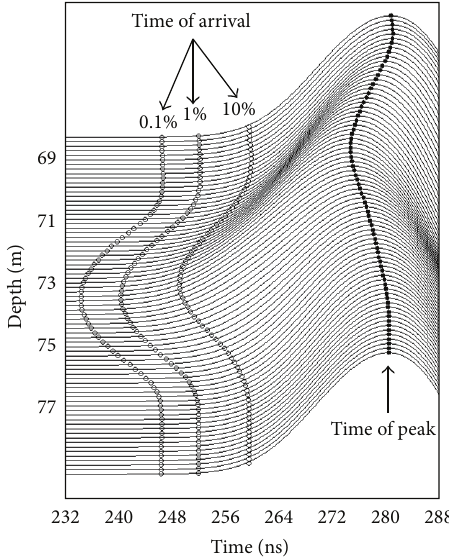
Figure 5: B-scan image of a partially water-filled tunnel ( 𝐻 0.5 ) and the time of arrival with 3 different amplitude levels of 10%, 1%, and 0.1%.